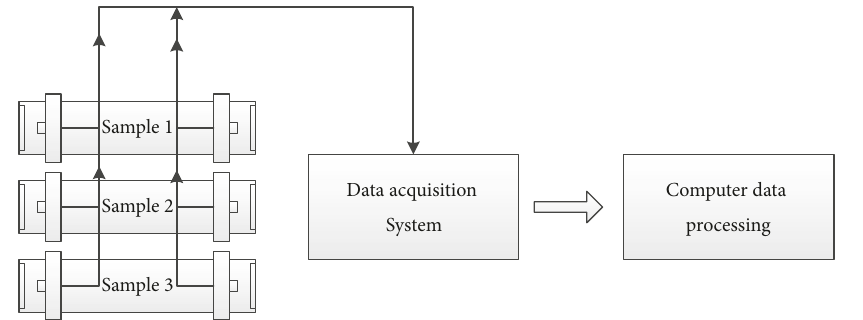
Figure 4: Schematic diagram of the UHPC autogenous shrinkage test.